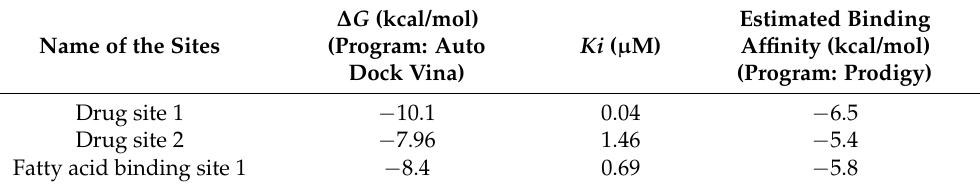
Table 5. Estimated binding free energy and the estimated inhibition constant of three sites of human serum albumin with indomethacin.